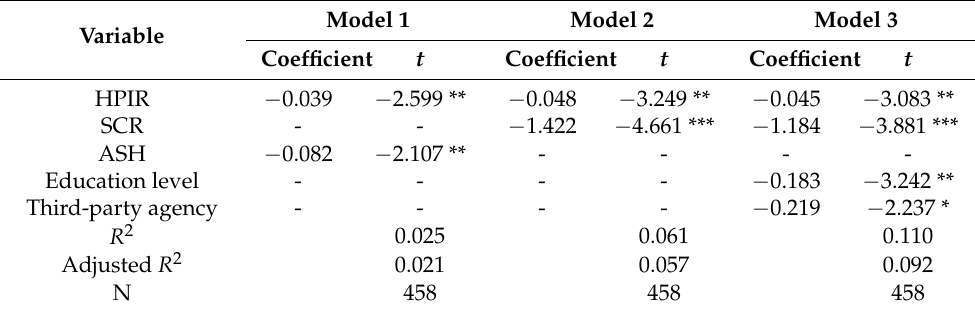
Table 5. The impacts of various factors on actors’ supportive perception.